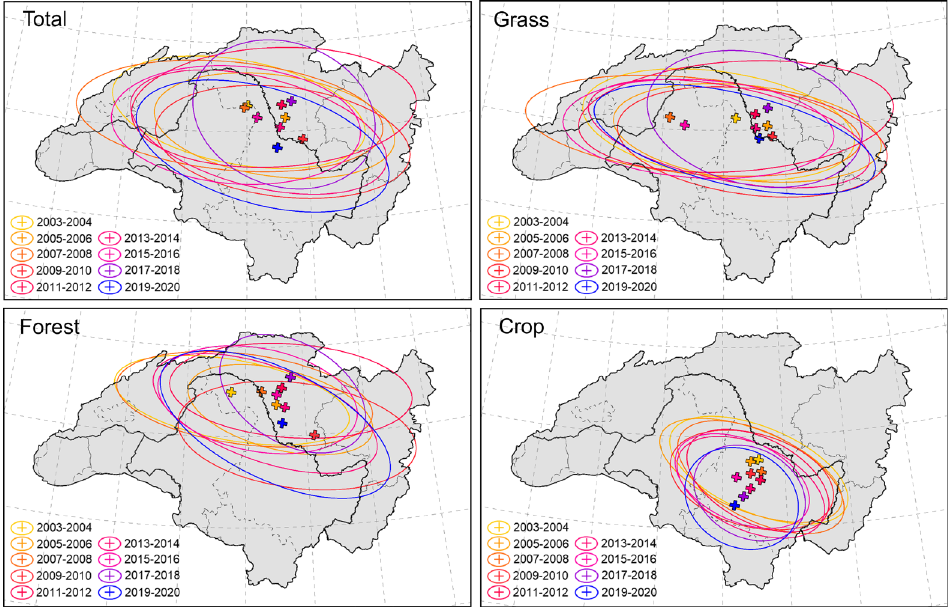
Figure 5. The spatial changes in the median center and standard deviation ellipse of annual CO 2 emissions between 2003 and 2020.